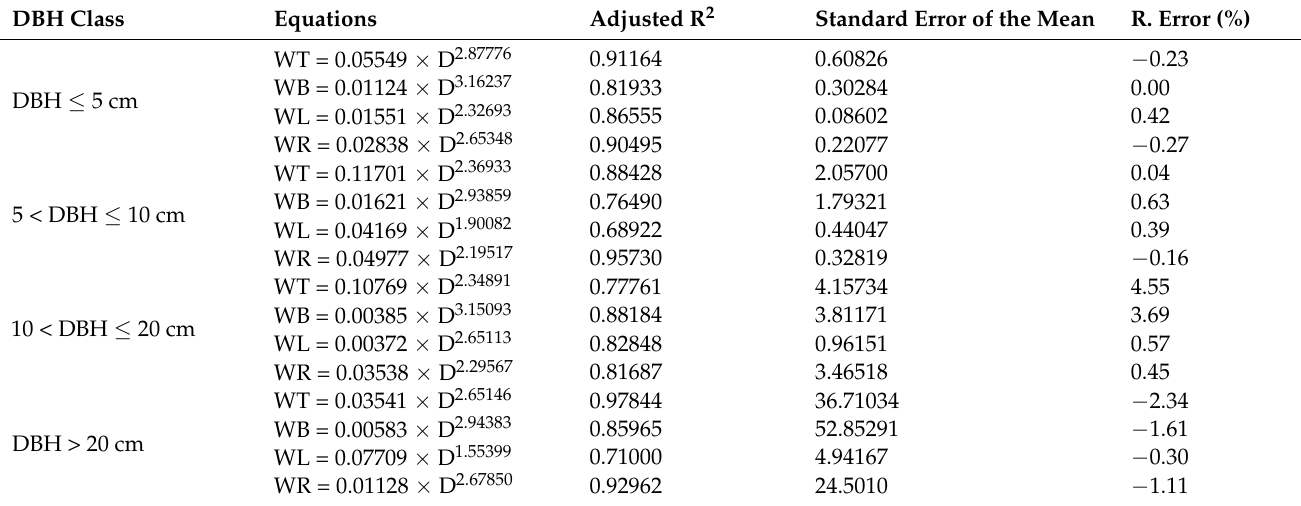
Table A1. Allometric regression equations and summary